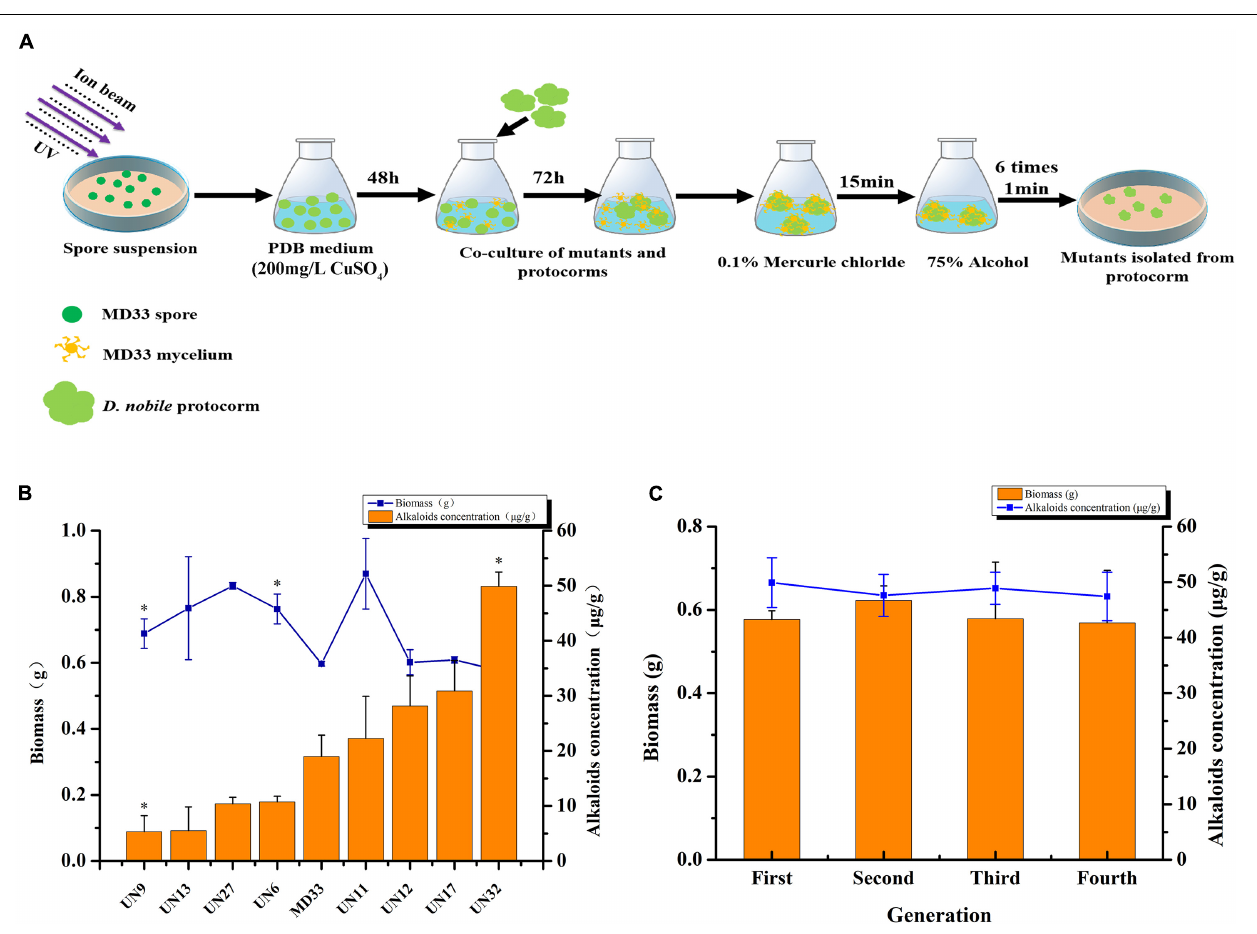
FIGURE 1 | Ultraviolet rays and N + implantation of T. longibrachiatum MD33 to increase total alkaloids production. (A) Schematic illustration of the mutants screening process. (B) Comparison of total alkaloids production and biomass between MD33 with its mutants. (C) Dry weight (g) and total alkaloids production ( µ g/g) of UN32 strain grown for four successive generation. Asterisks indicate significant differences; one asterisk represents p <